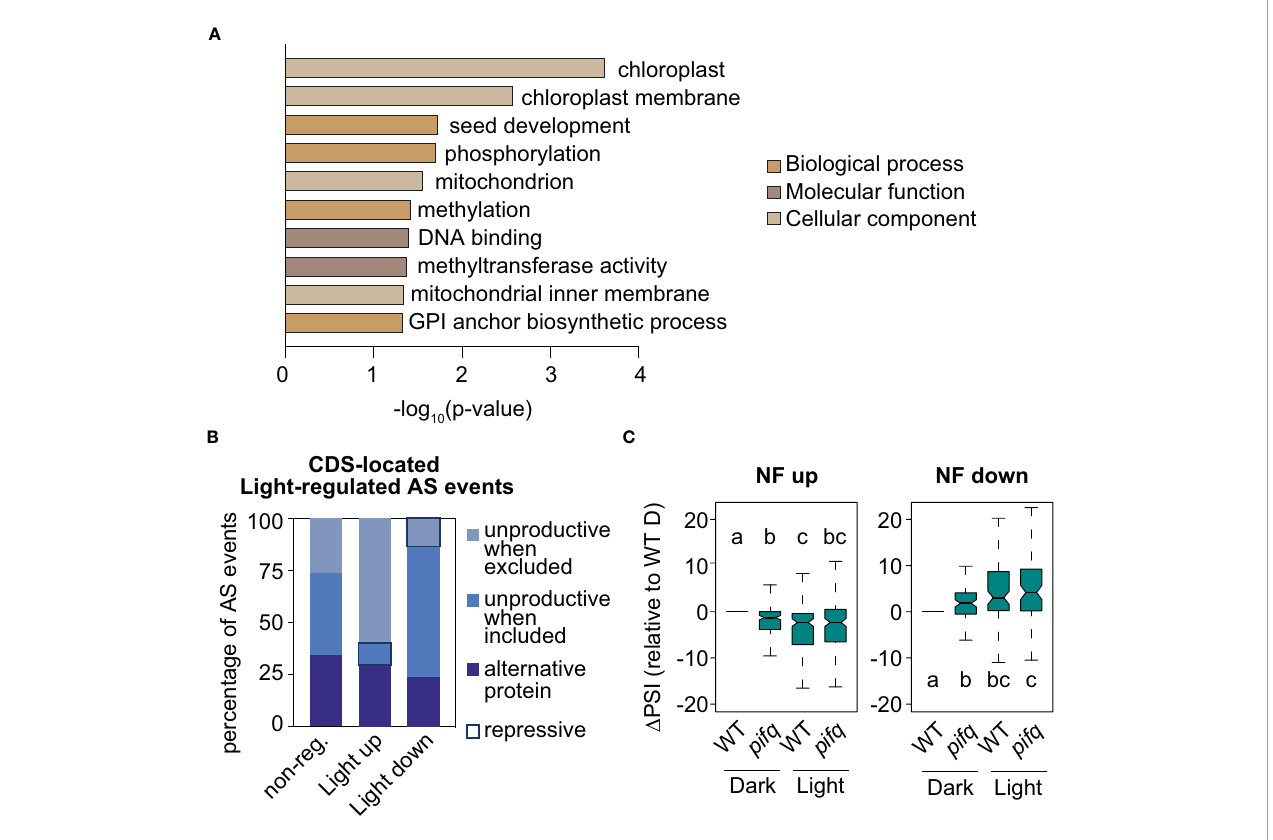
FIGURE 6 Light regulation of NF-regulated AS events. (A) Enriched gene ontology categories of the 247 genes de fi ned as differentially spliced between dark and light conditions. DAVID p-value indicates signi fi cance (Fisher ’ s exact test; P < 0.05). (B) Percentage of light-regulated AS events located in the coding gene region that potentially produce unproductive mRNAs or alternative protein isoforms (see Material and Methods for details) in three different groups of AS events: non-regulated (non-reg.), up- or downregulated by light. Repressive AS events are highlighted. (C) Boxplot representation of the Δ PSI between wild-type (WT) and pifq seedlings grown in continuous light or darkness in respect of dark-grown WTs (WT D) of AS events up- or downregulated by nor fl urazon (NF). Letters denote the statistically signi fi cant differences between medians (Kruskal-Wallis; P <